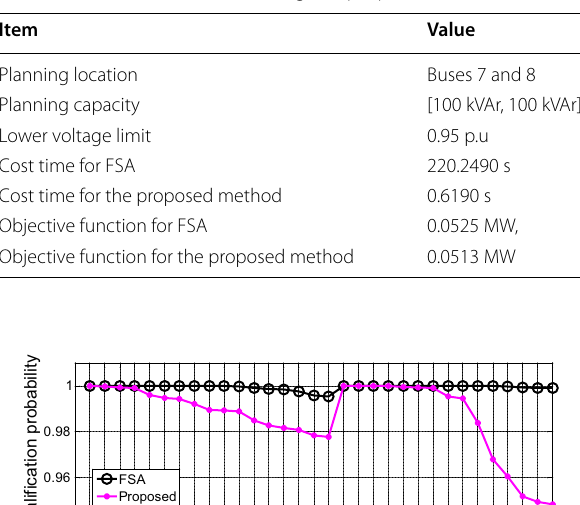
Table 12 Simulation results using the proposed method